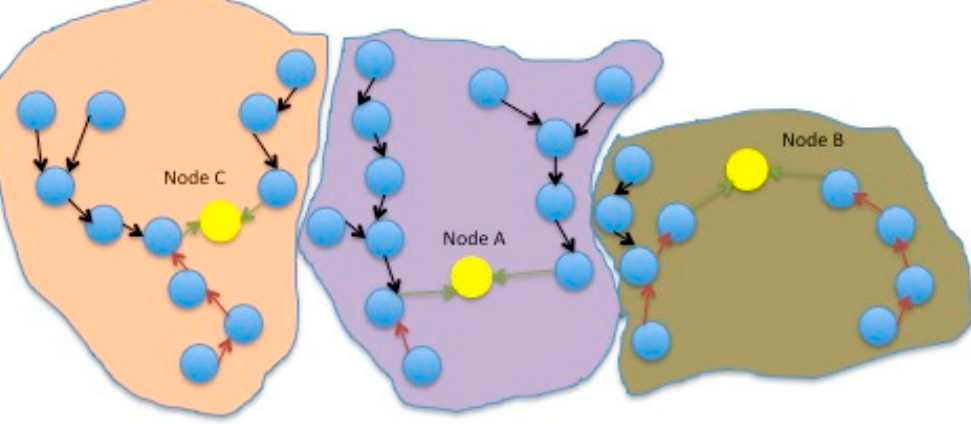
Figure 5. Phases 3 and 4: structured network and maturity. Non-affected links (black arrows). Reversal of the direction of information flow (red arrows). Creation of new links both between motes and between a mote and the node (green arrows).